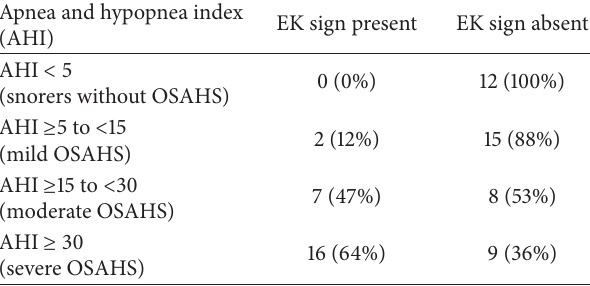
Figure 1: Wrinkling of uvula (EK sign) in obstructive sleep apnea- hypopnea syndrome.